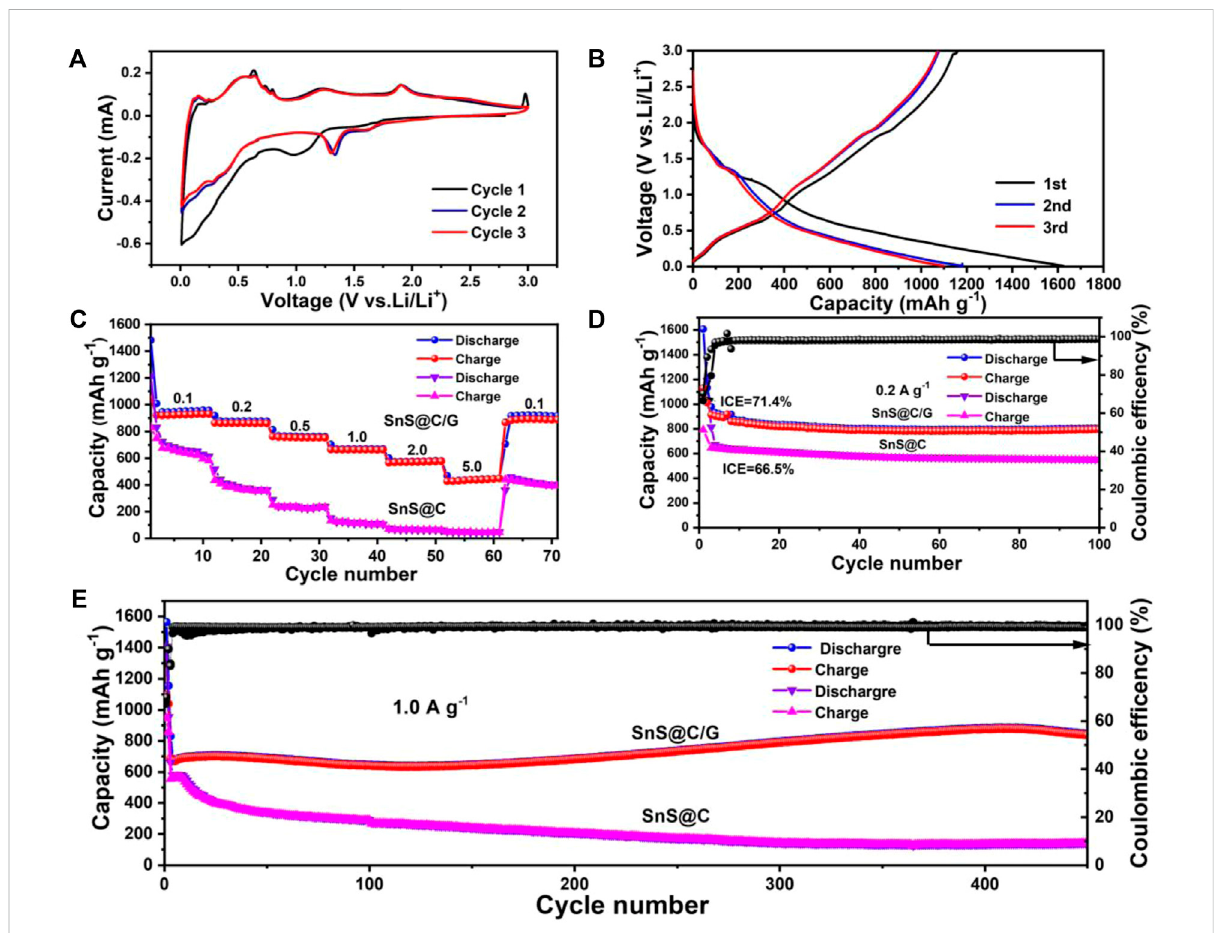
FIGURE 4 Electrochemical performances of composites for lithium batteries: (A) CV curves at a scanning rate of .1 mV s − 1 and (B) charge and discharge voltage pro fi les of the SnS@C/G composite for the fi rst three cycles at 0.1A g − 1 ; (C) Rate performances, (D) cycling performance at .2 A g − 1 , and (E) long-term cycling performance at 1.0 A g − 1 of SnS@C/G and SnS@C